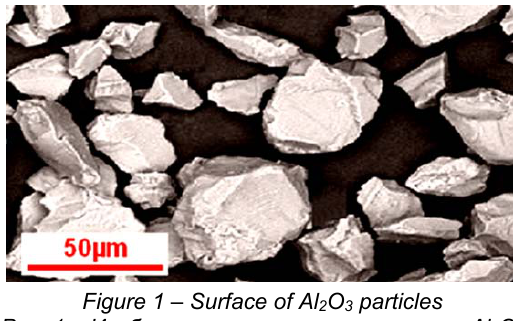
Figure 1 – Surface of Al 2 O 3 particles Рис . 1 – Изображение поверхности частиц Al 2 O 3 Слика 1 – Изглед површине Al 2 O 3